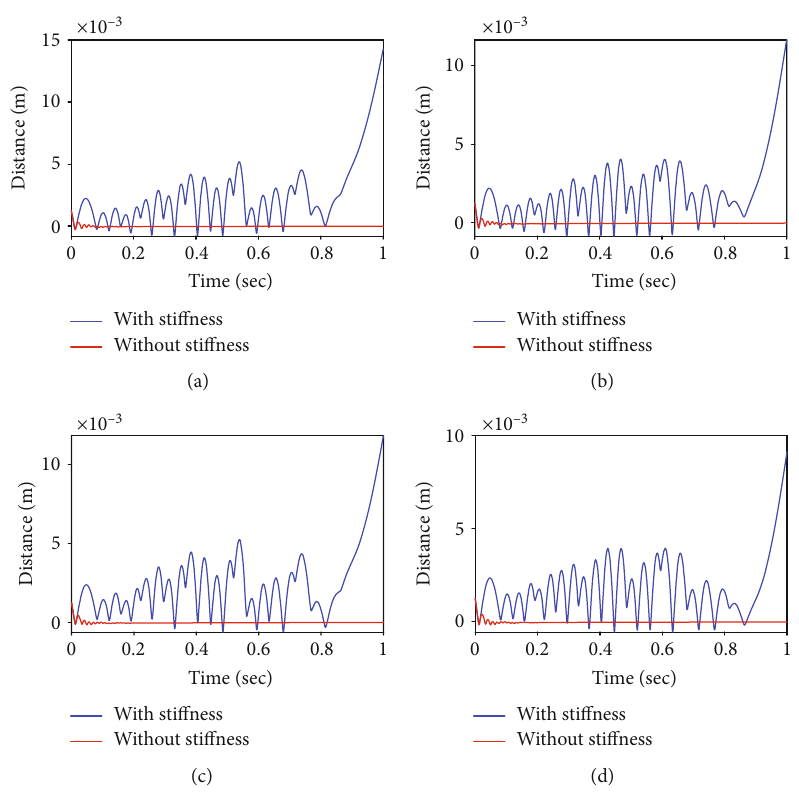
Figure 12: Initial con fi guration of space robot and noncooperative satellite.